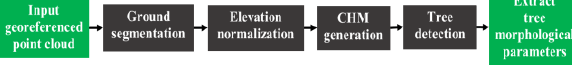
Figure 7. The data processing methodology workflow for extraction of tree morphological parameters.